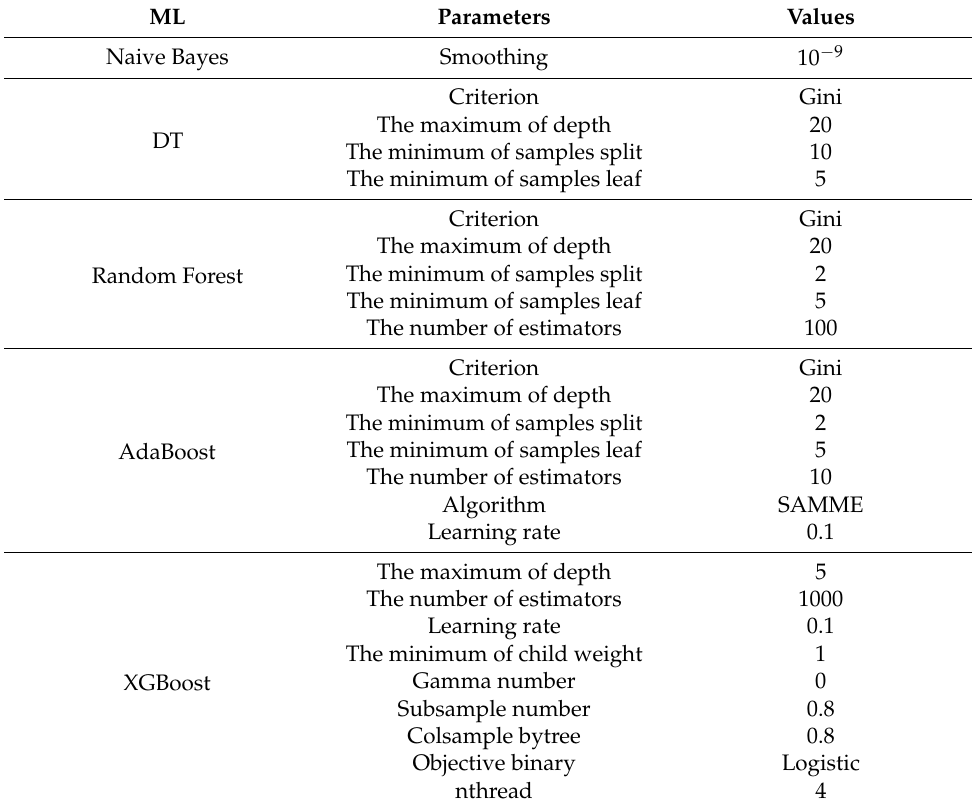
Table 2. Parameters and settings required for the machine learning